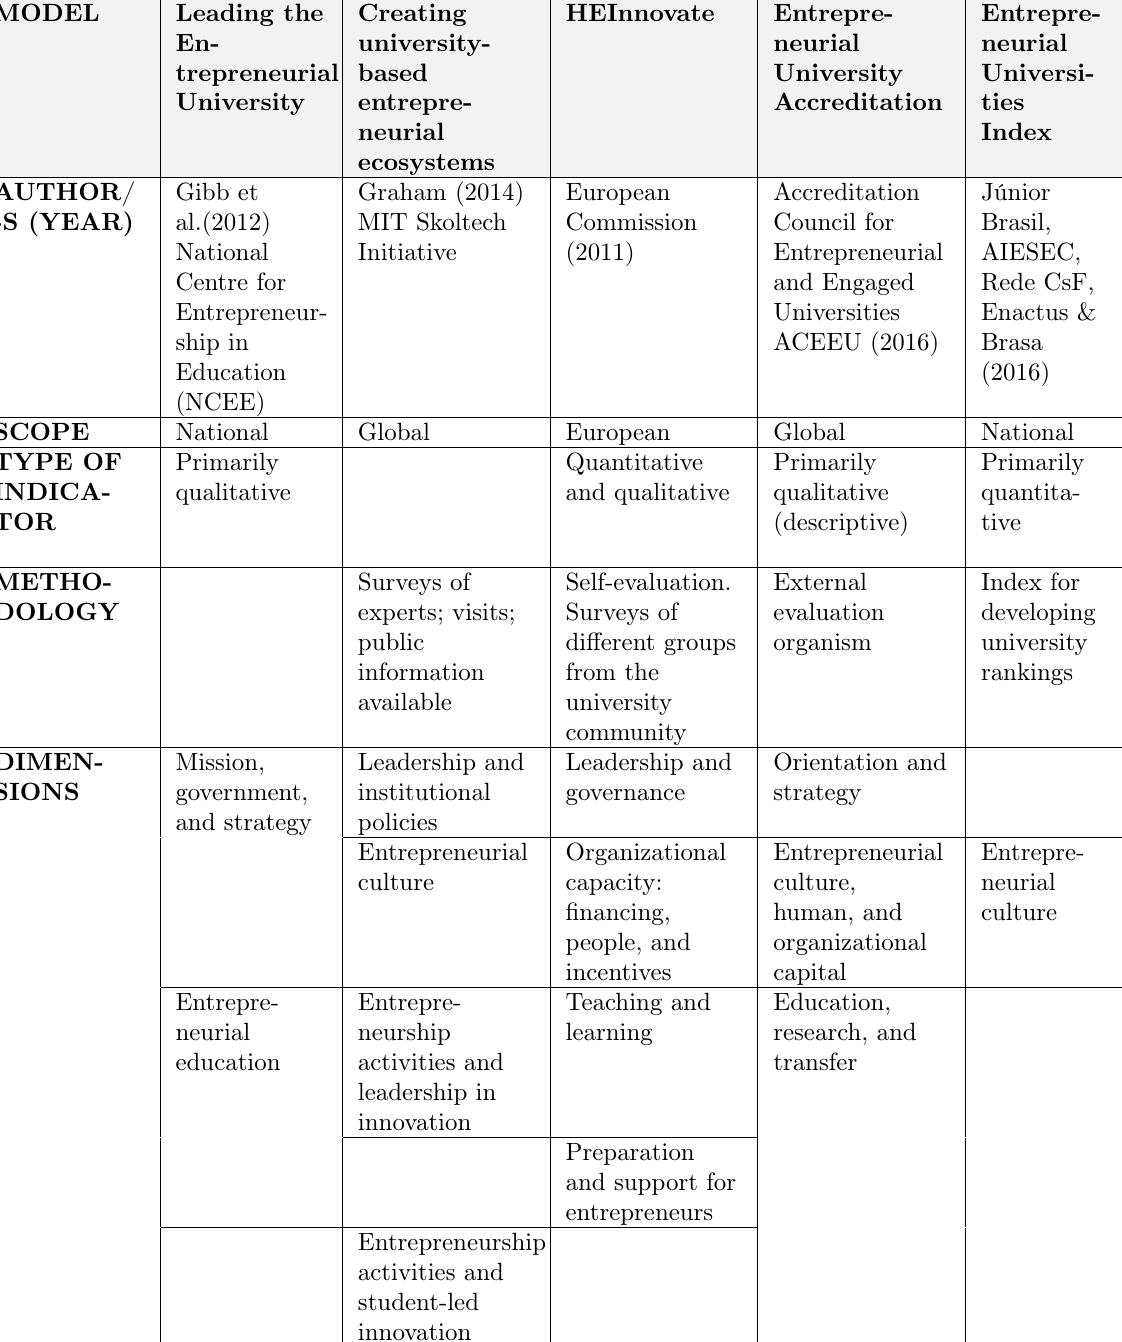
Table 1. Models that identify the entrepreneurial profile of a university: comparative analy- sis